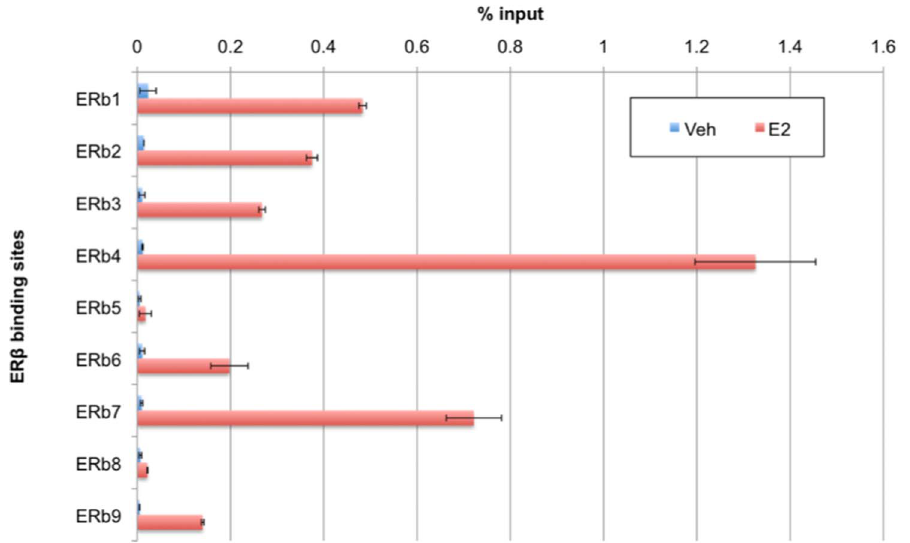
Figure 2. Validation of ER b binding regions in C4–12/Flag.ER b cells by ChIP-qPCR. After 1 hour of E2 treatment, C4–12/Flag.ER b cells were subjected to ChIP assay using anti-Flag M2 antibody. Recruitment of ER b to representative sites was confirmed with qPCR. (Error bars=standard deviation).